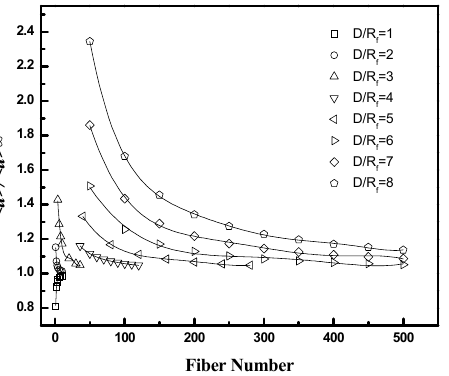
Figure 12. < u >/< u > ∞ as a function of fiber packing fraction or D/R f for square packing ; left ( D/R f = 2, and fiber number = 10), right ( ϕ = 0.4, and fiber number = 10).